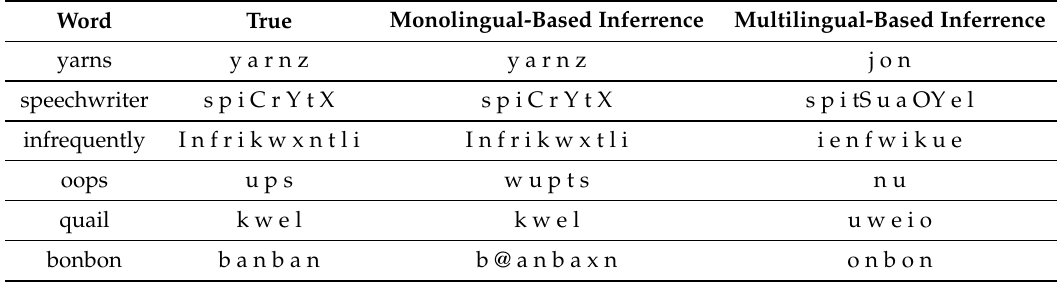
Table 7. Examples of phonetics inference according to the monolingual KL-HMM and multilingual